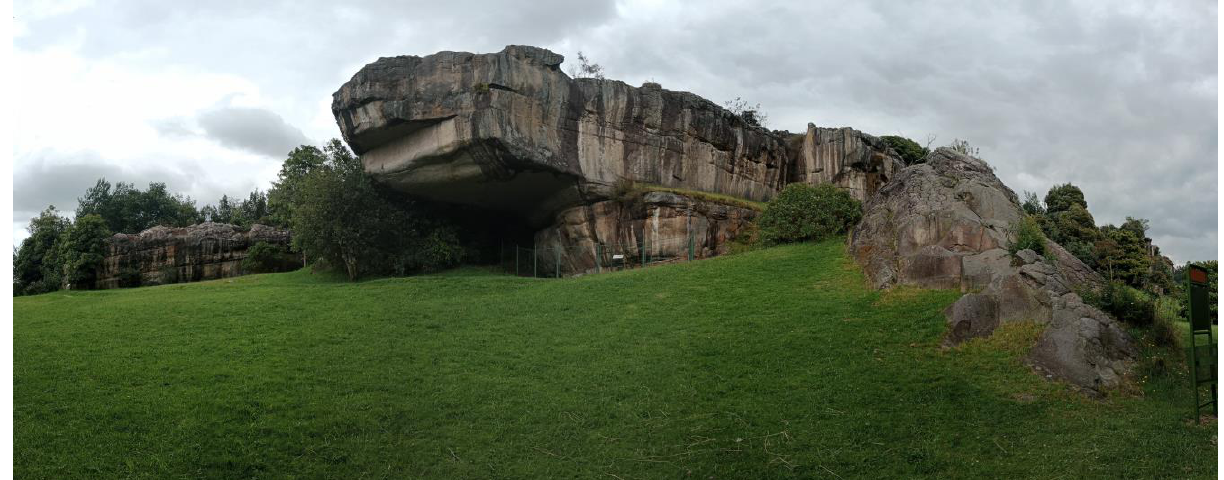
Figure 1. Stones of Tunjo. Rock in the form of a "snake". Own source.